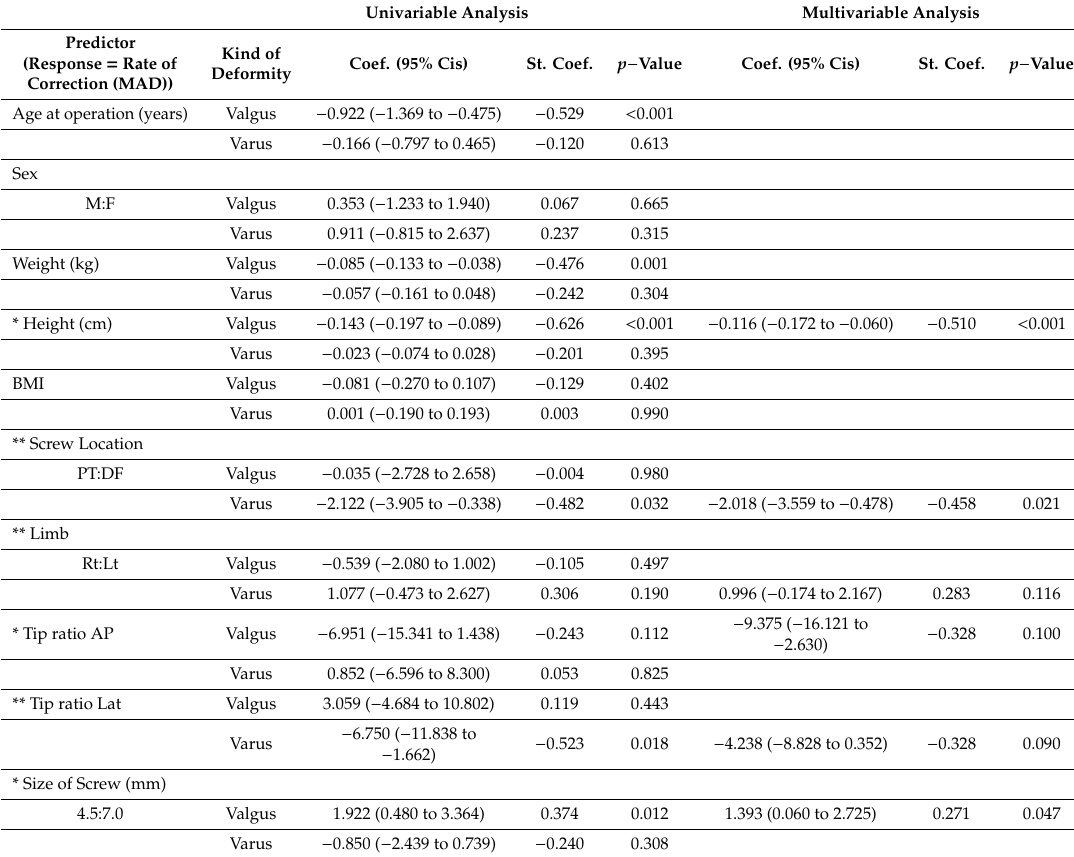
Table 7. Results of univariable and multivariable linear regression analysis using correction rate (MAD) as a response in valgus and varus